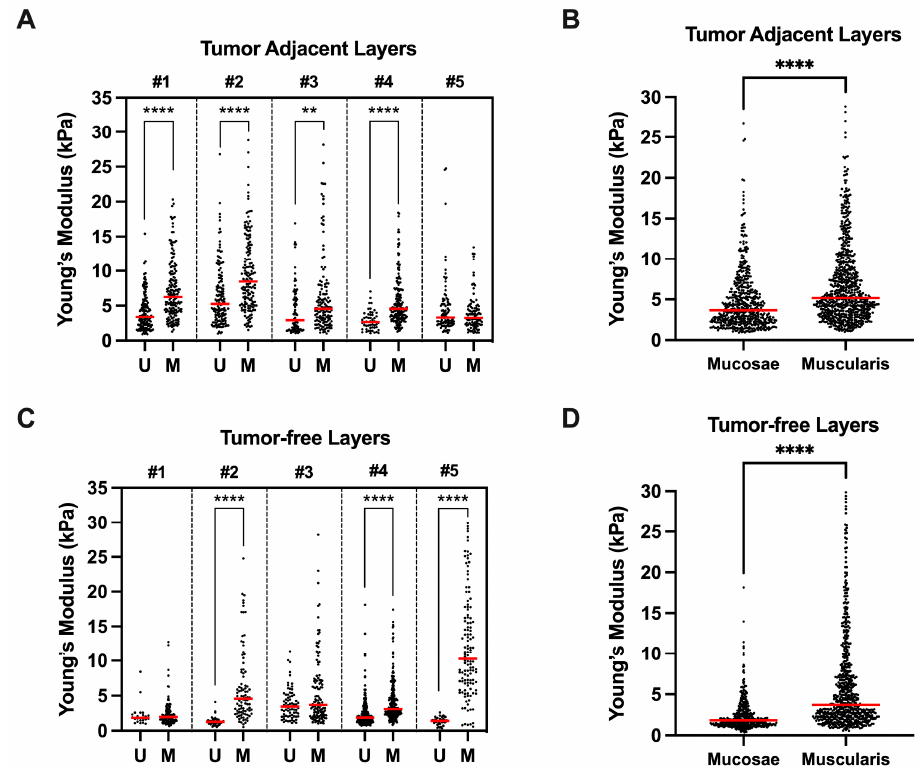
Figure 3. ( A , C ) Comparison between bladder wall layers (mucosae (U) vs. muscularis propria (M)) Young’s moduli for each patient according to differently located tissue samples (tumor-adjacent or tumor-free). ( B , D ) Mean Young’s moduli of all mucosae vs. muscularis propria measurements according to differently located tissue samples. ** p < 0.001, **** p < 0.0001. Both mucosa and muscularis propria stiffness was increased in tumor-adjacent tissues. The mucosa had a significantly higher Young’s modulus in tumor-adjacent tissues than in tumor-free tissues ( p **** < 1 × 10 − 4 , Figure 4A). Likewise, the muscularis propria had a significantly higher Young’s modulus in tumor-adjacent tissues than in tumor-free tissues ( p **** < 1 × 10 − 4 , Figure 4B).